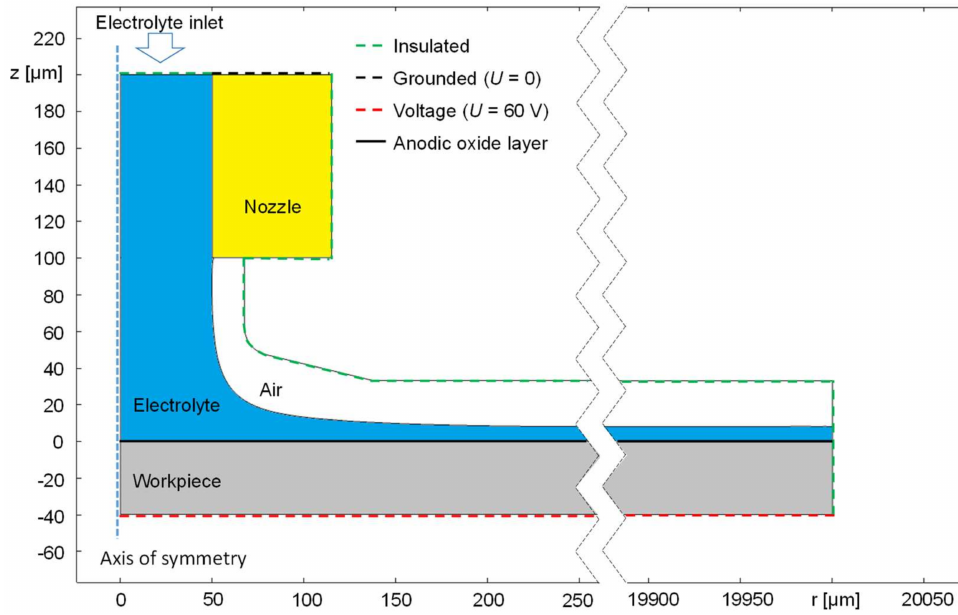
Figure 3. Geometry and electrical boundary conditions of the rotation-symmetric simulation model of jet-based